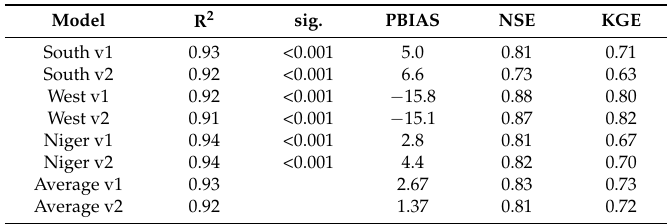
Table 4. Actual Evapotranspiration Validation against MODIS MOD 16 Data.